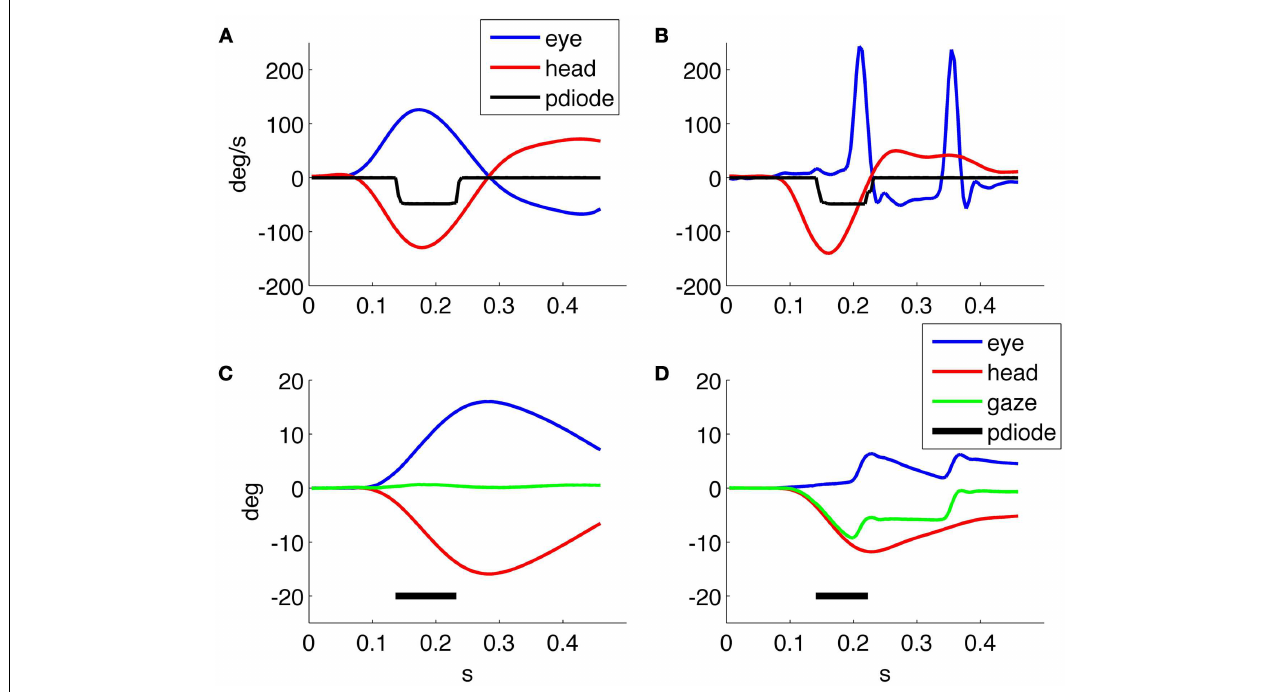
FIGURE 5 | (A,B) Head and eye velocity response, and optotype presentation from a normal subject and a patient, respectively, with (left) unilateral vestibular neuritis. (C,D) Head, eye, and gaze position, together with optotype timing for the responses in (A,B) , respectively.